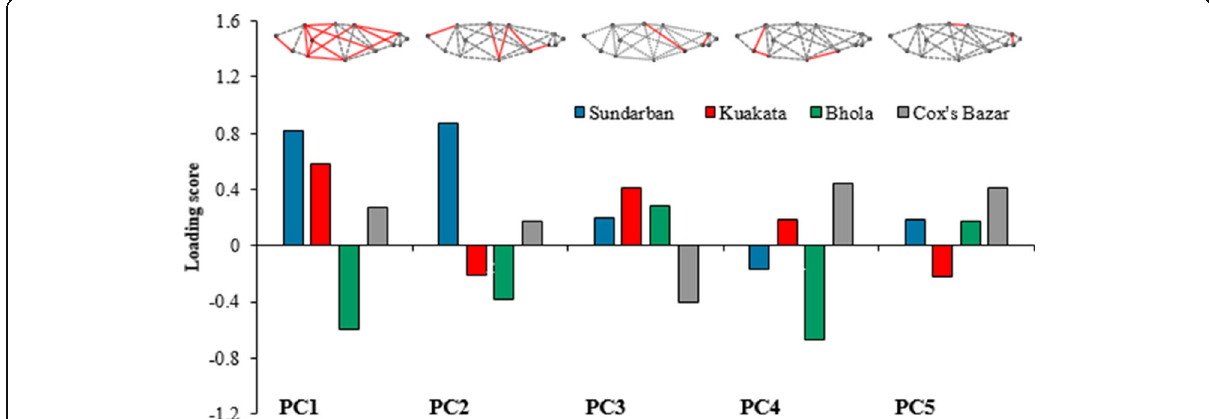
Fig. 5 Variation for the five components in the principle component analysis (PCA) of A. clupeoides collected from the four sampling points along the Bay of Bengal coast,